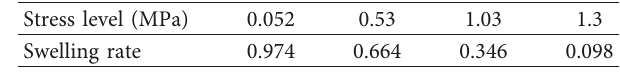
Table 3: Axial stress and swelling deformation scale.